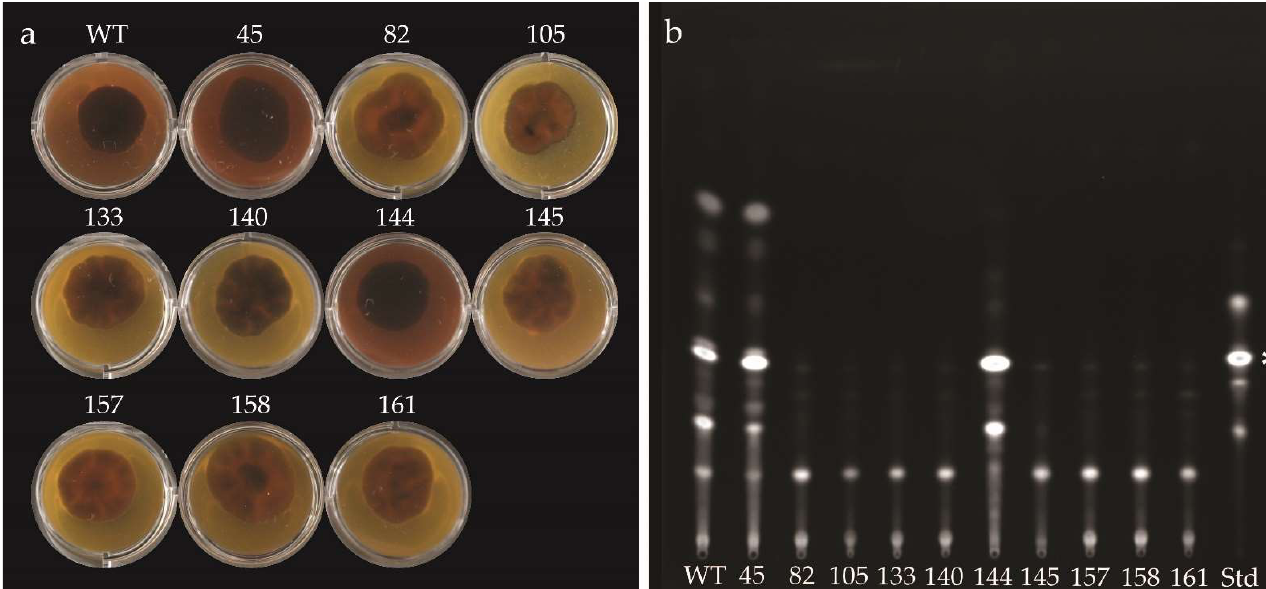
Figure 1. Presence or absence of dothistromin from wild-type (WT) Dothistroma septosporum and CRISPR/Cas9 AflR transformants selected for investigation. ( a ) Visual analysis of dothistromin production when grown on Dothistroma medium (DM) supplemented with 100 µg/mL CuSO 4 .5H 2 O (known to enhance dothistromin production; Figure S2). Presence of dothistromin shown by red- brown pigmentation of the media, as seen in DM supporting growth of WT fungus, and transformants 45 and 144. Transformants were photographed 4 weeks postinoculation. ( b ) Thin-layer chromatography (TLC) analysing dothistromin production in AflR transformants and WT fungus. Position of dothistromin is shown in standard (Std), highlighted with a white asterisk. Dothistromin was visible in samples representing WT fungus, and transformants 45 and 144.